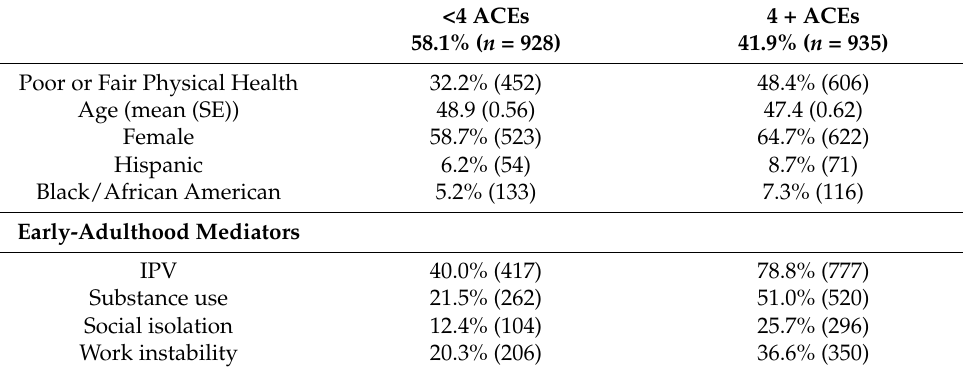
Table 1. Characteristics of study population.